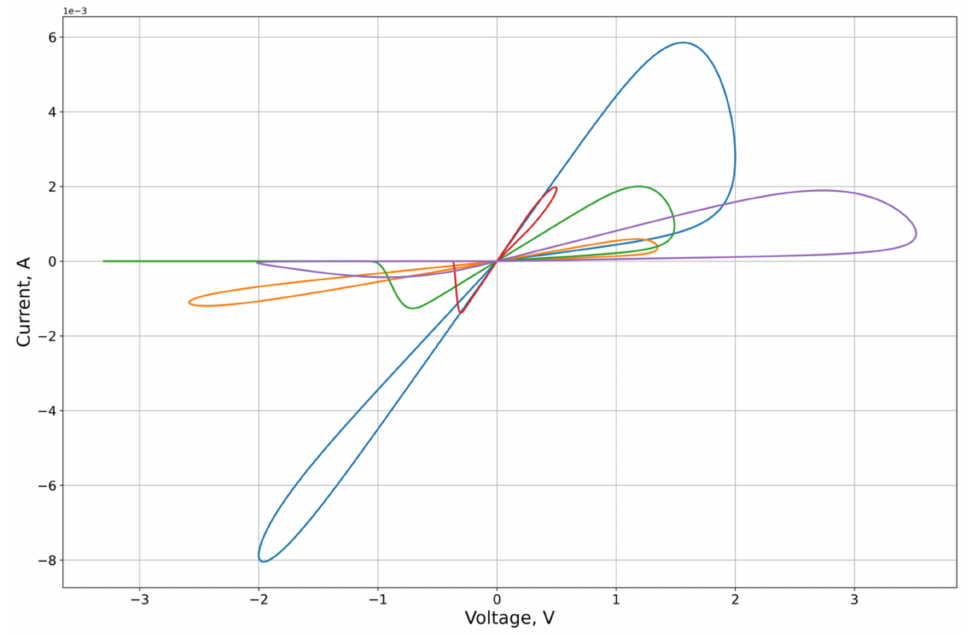
Figure 7. Results of the optimization of the right lobe of the synthetic sampling circuits (Figure 3) by the